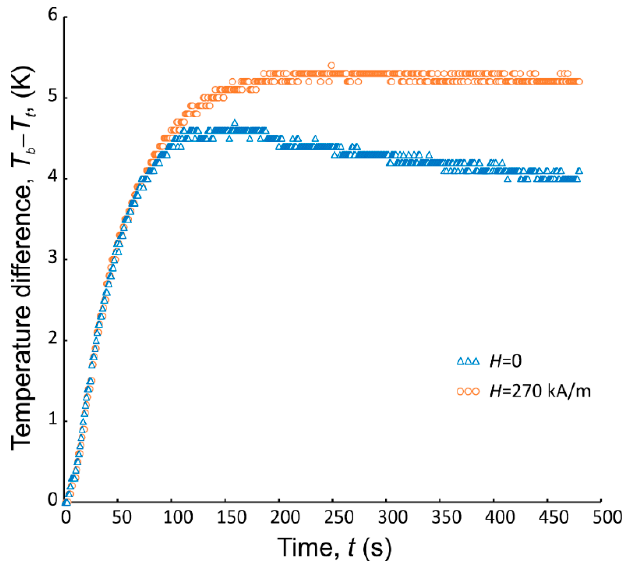
Figure 7. The temperature difference between the bottom and top plates during heating the bottom plate as a function of time. The results obtained in the absence and under the influence of a magnetic field are shown.